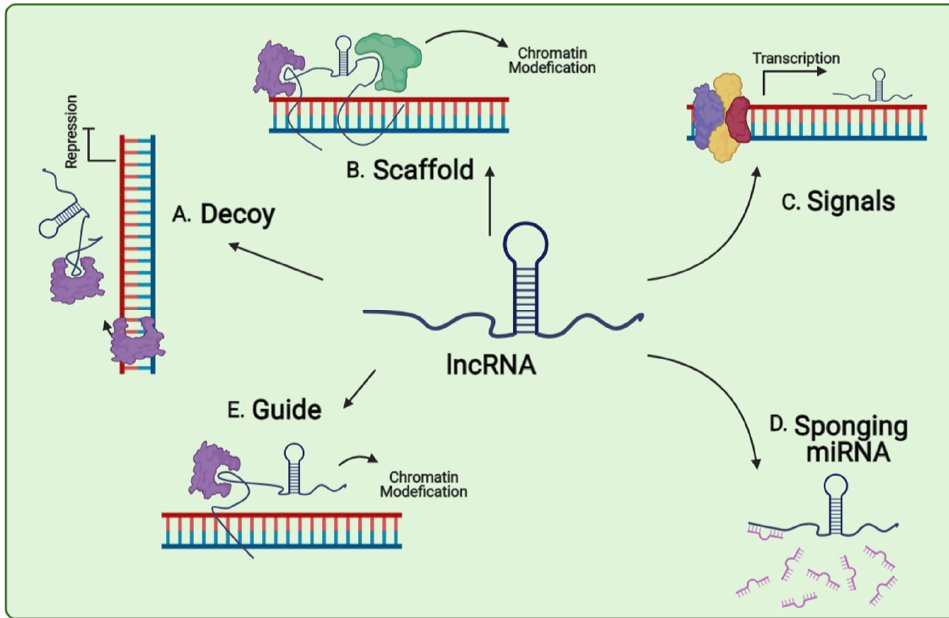
Figure 2. Overview of lncRNAs functions. Decoy lncRNAs can sponge protein factors such as transcription factors and chromatin modifiers ( A ). Scaffold lncRNA is involved in assembly of complex protein complexes ( B ). Signals lncRNAs can serve as molecular signals and can act as markers of functionally significant biological events ( C ). Sponging miRNA lncRNA participate in miRNA inactivation by sponging them ( D ). Guide lncRNAs can be molecular guides by localizing particular ribonucleoprotein complexes to specific chromatin targets ( E ).